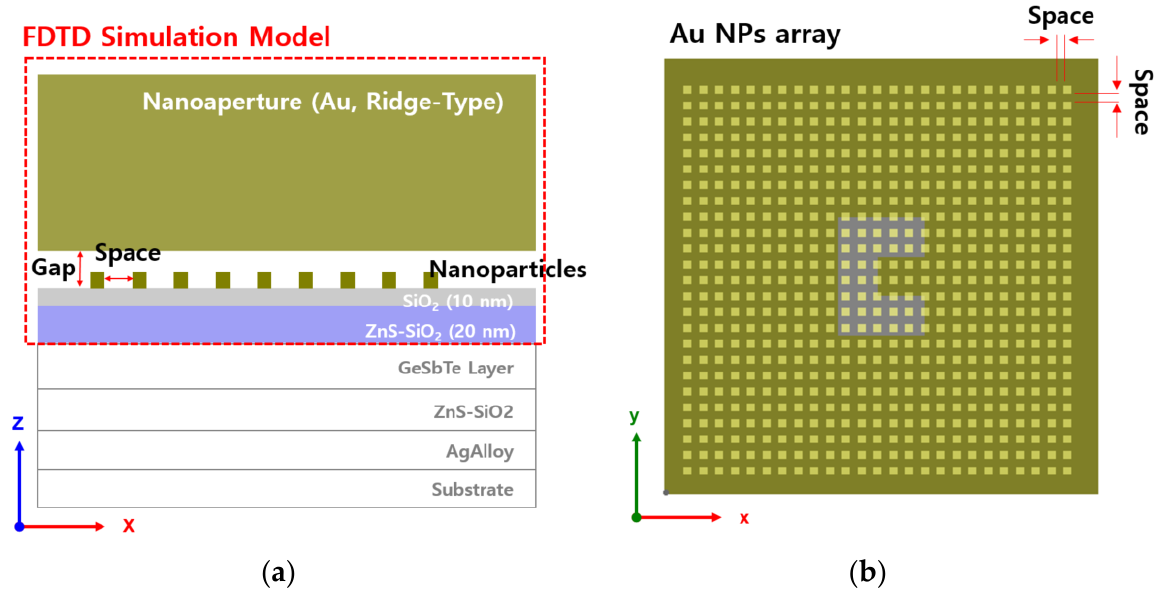
Figure 3. Au NPs array deposited media with ridge-type nanoaperture: ( a ) in the y-z plane; ( b ) in the x-y plane.